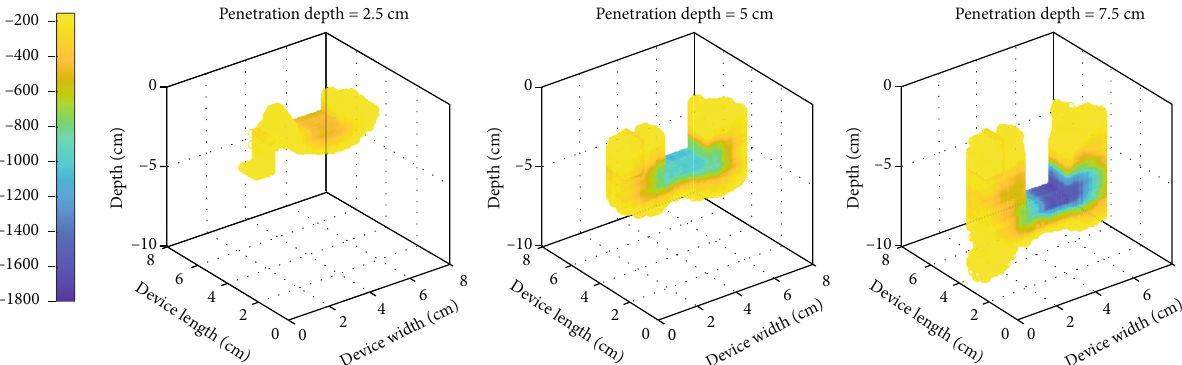
Figure 13: In fl uence zone with di ff erent penetration depths